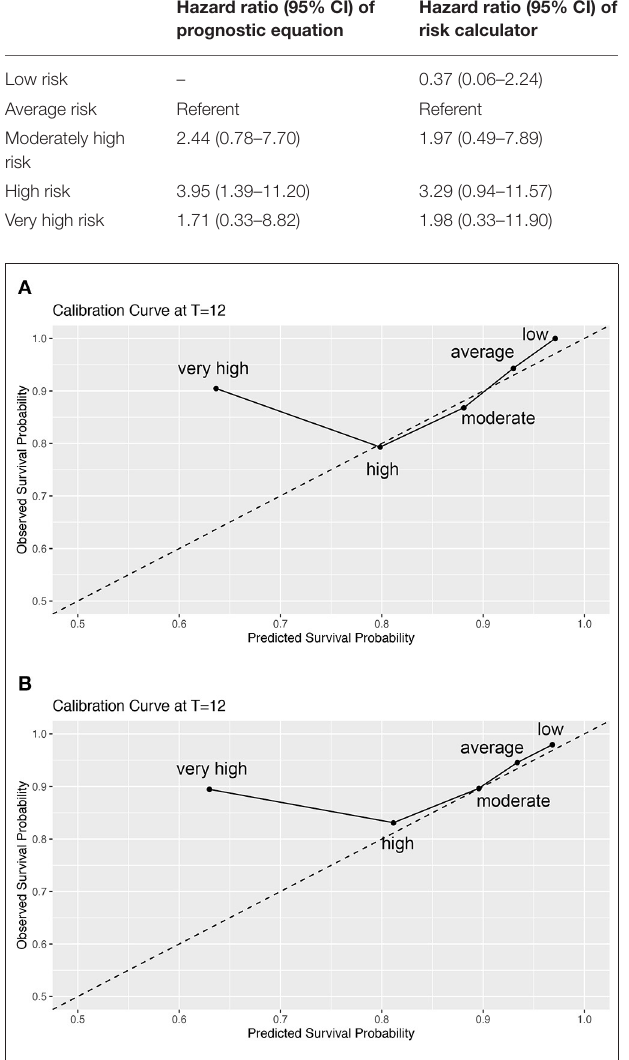
( Table 3 ), indicating that model discrimination and calibration were inaccurate for patients in the very high-risk